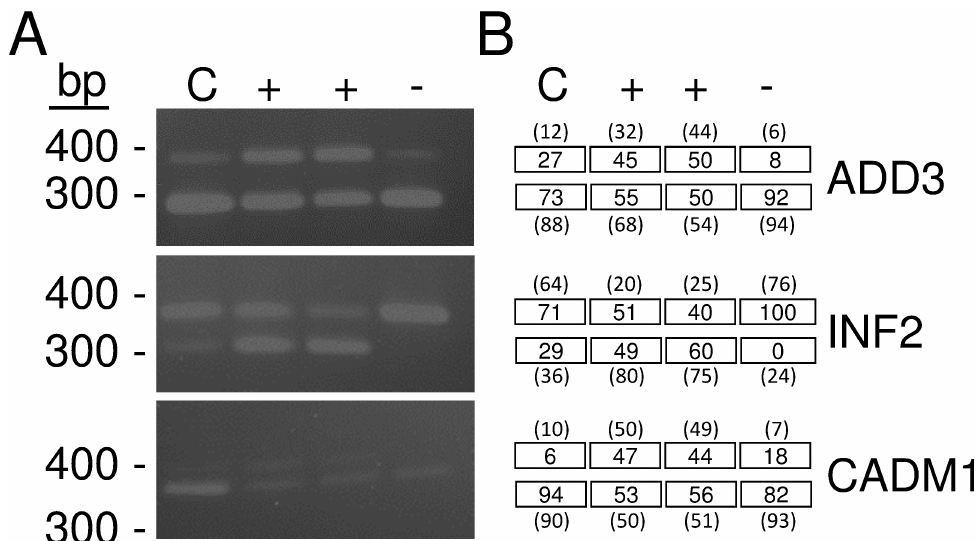
Fig 1. Validation of RNA Sequencing identified mis-splicing events. (A) RT-PCR amplified products derived from specific primers (Table 2) that flanked selected exons in the ADD3, INF2, and CADM1 genes. Amplification of a larger DNA fragment in ADD3 and CADM1 (exon inclusion) and a smaller DNA fragment in INF2 (exon exclusion) are shown in samples obtained from two independent FECD patients that have a TCF4 trinucleotide repeat expansion (denoted with a plus sign). In contrast, these bands are either lacking or in reduced amounts in a sample from a FECD patient that does not contain a TCF4 trinucleotide repeat expansion (denoted with a minus sign) or a non-FECD patient sample (labeled with a C). (B) Numbers in boxes represent percentage of PCR products containing inclusion/exclusion of exons for each sample in (A). Numbers in parentheses are percent spliced in values obtained from RNASeq on the same samples from which PCR was performed. These results confirm exon inclusion and exclusion as identified by RNA sequence and PCR